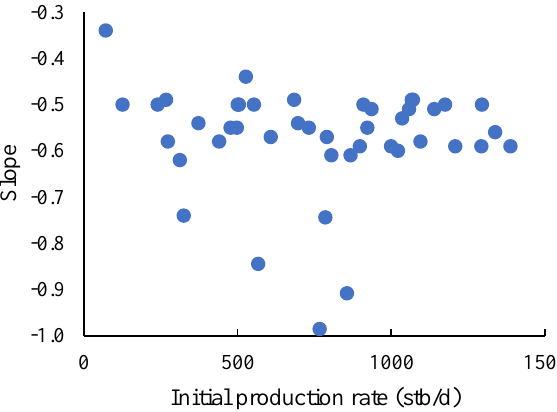
Figure 5. Statistical results of slopes used to identify reservoir linear flow (RLF).